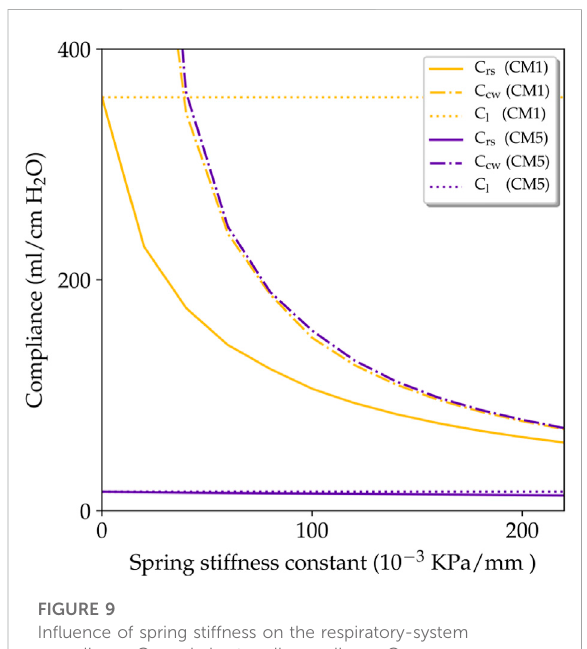
FIGURE 9 In fl uence of spring stiffness on the respiratory-system compliance C rs and chest-wall compliance C cw